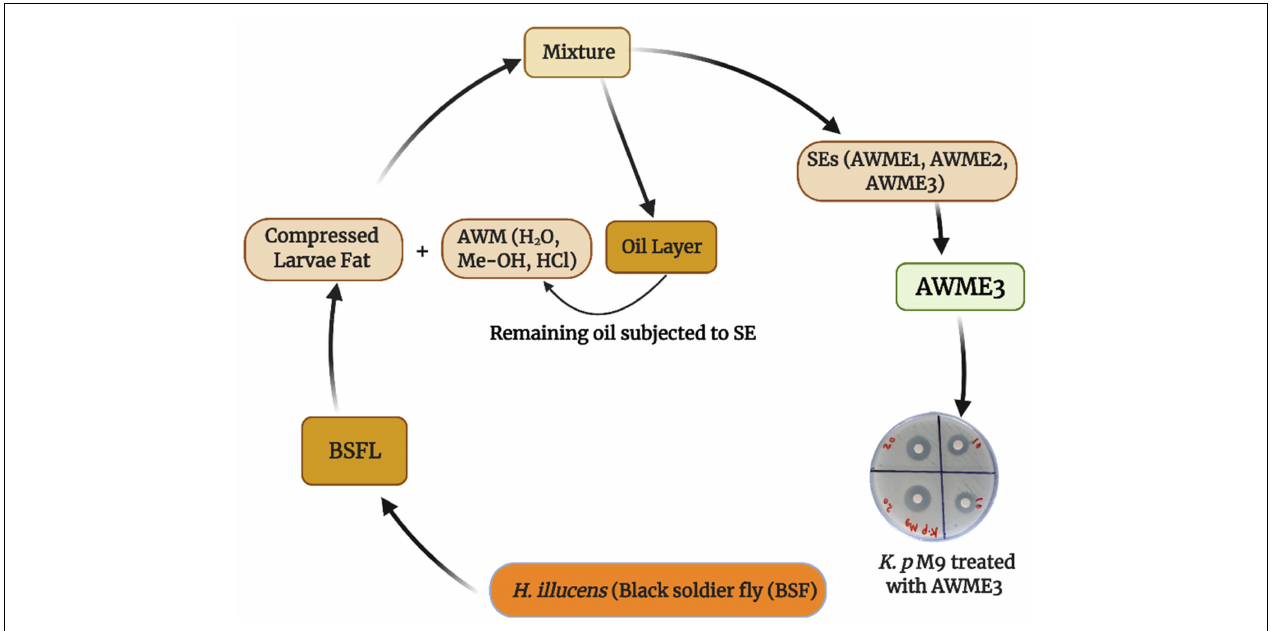
FIGURE 1 | Schematic diagram for isolation of bioactive compounds from H. illucens larvae fat using sequential extraction procedure.